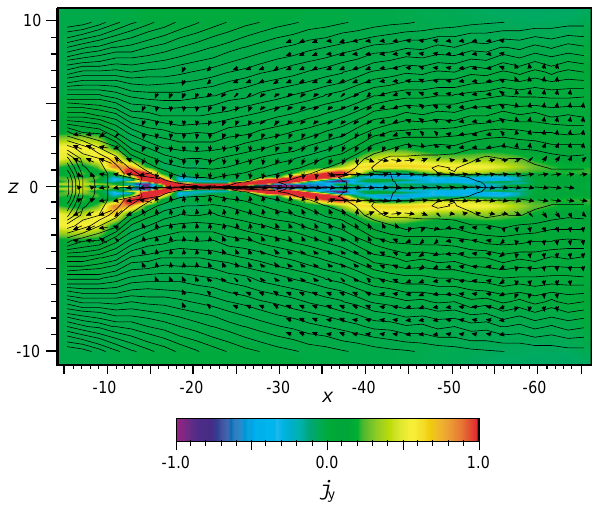
Fig. 1. Magnetic field lines, cross-tail current density (color), and energy flow vectors (arrows) in the midnight meridianal plane, y = 0, at t = 80, based on a simulation of magnetotail dynamics (Birn and Hesse,